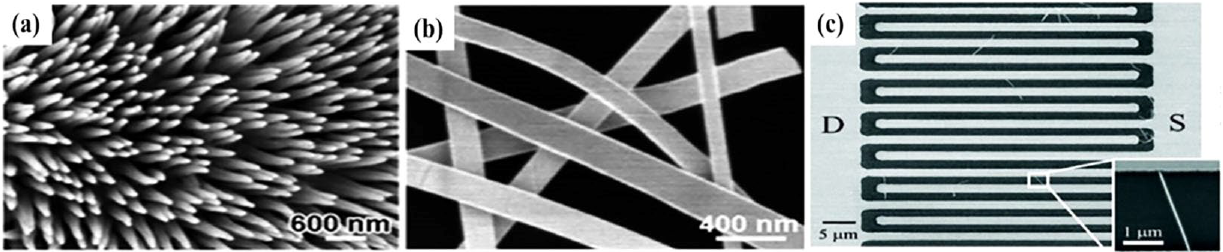
Figure 3. Vapor-phase-grown nanostructures: ( a ) ZnO nanowires; ( b ) SnO 2 nanobelts; Reproduced from Ref. [83] with permission from The Royal Society of Chemistry. ( c ) An example of randomly distributed In 2 O 3 NWs between source and drain during device integration. Reprinted with permission from Ref. [94]. Copyright © 2015, American Chemical Society.